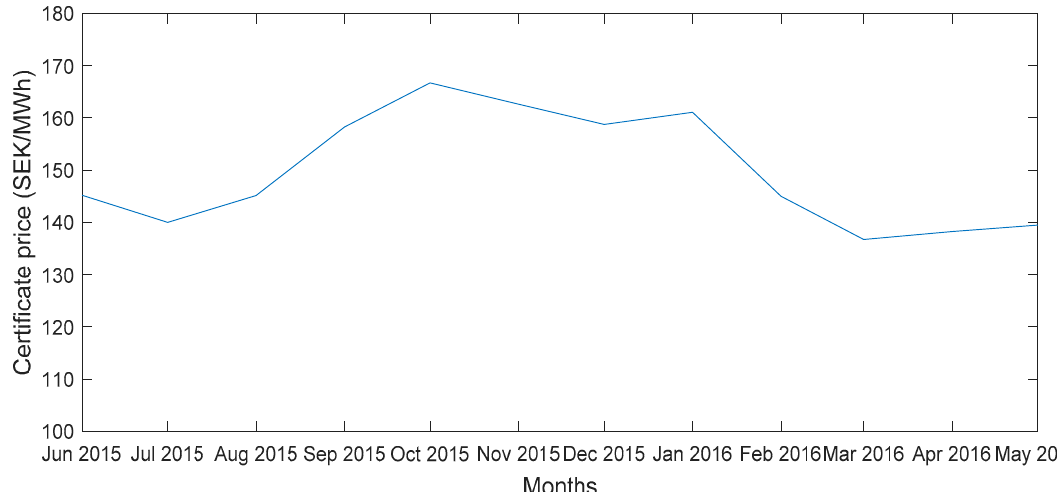
Figure 19. Monthly average TGC spot prices [39].